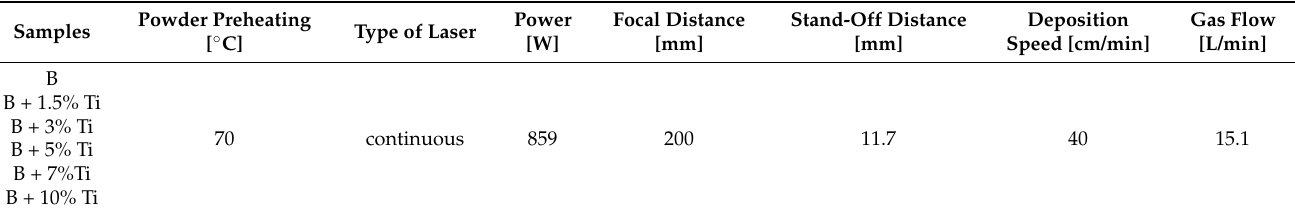
Table 1. Parameters for laser cladding deposition of samples.